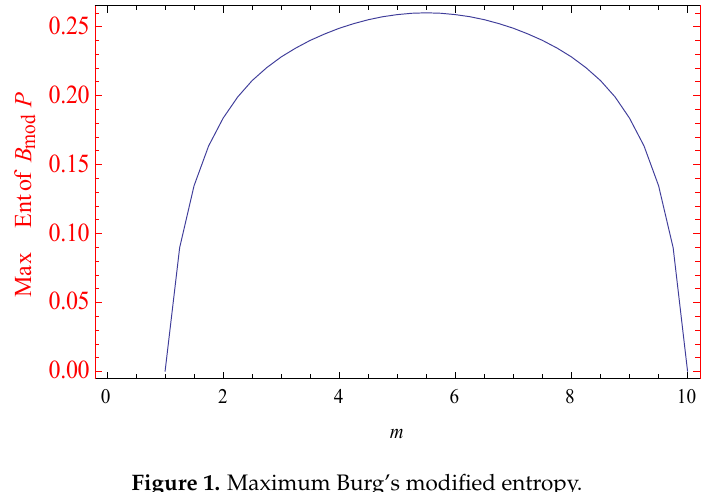
Figure 1. Maximum Burg’s modified entropy.